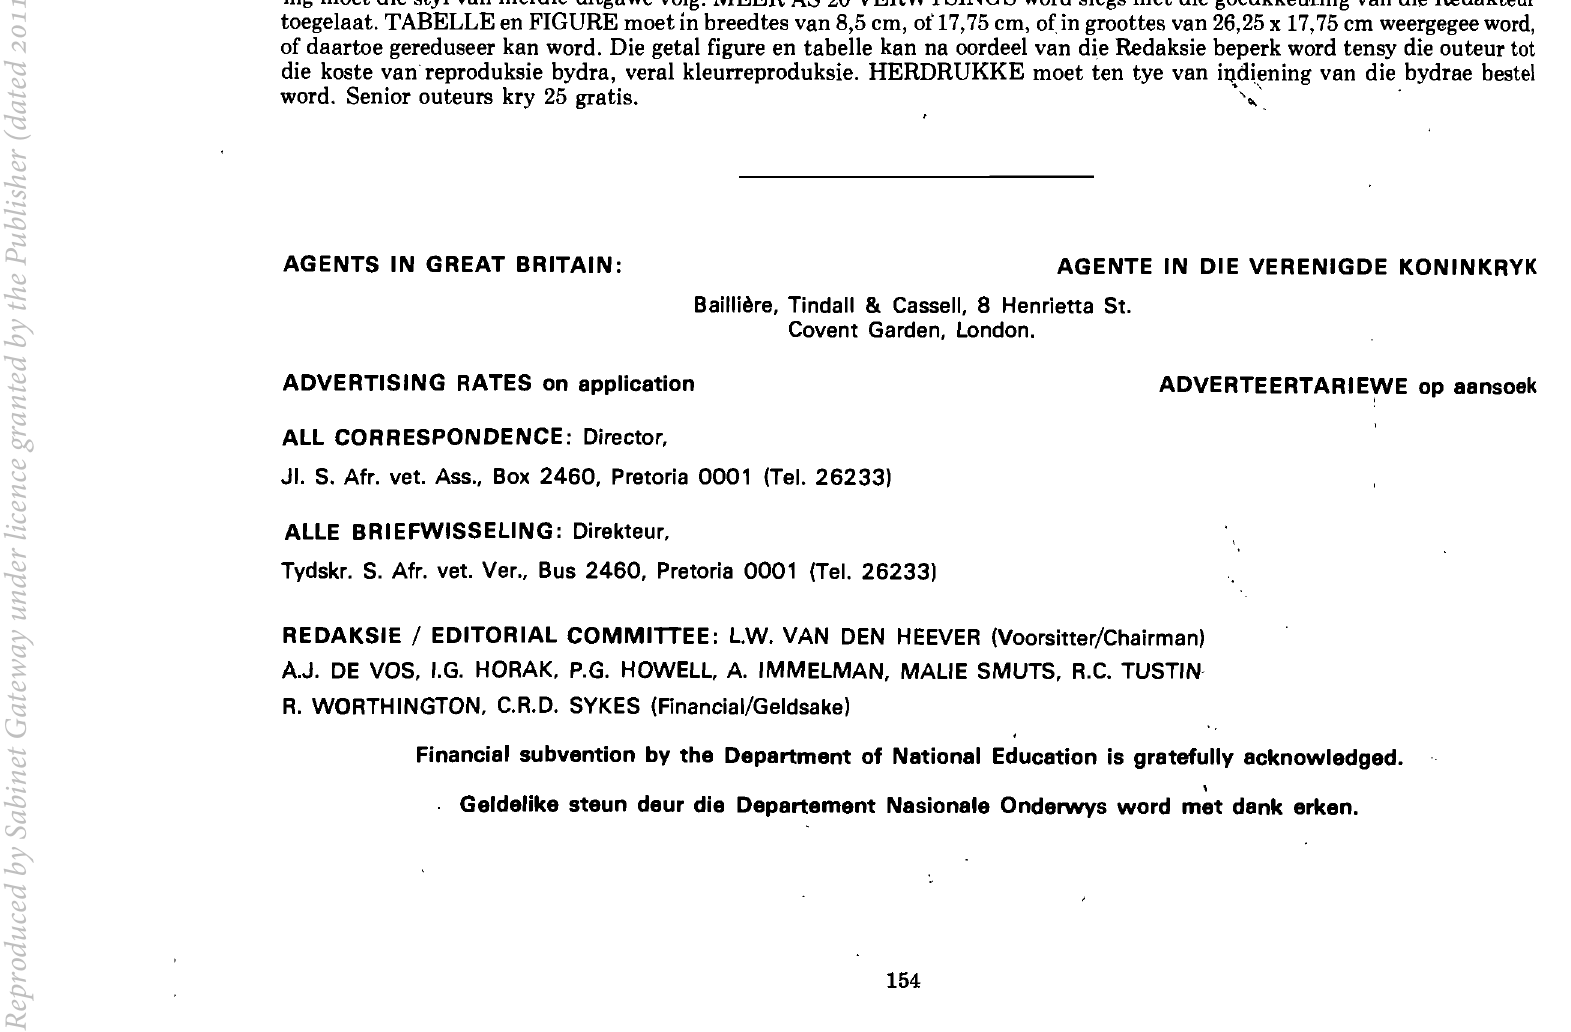
TYDSKRIF VAN DIE SUID-AFRIKAANSE VETERINERE VERENIGING Die TYDSKRIF is die offisiele mondstuk en eiendom van en word gepubliseer deur die Suid-Afrikaanse Veterinere Vereniging. Dit verskyn kwartaalliks en word aan sake van algemene veeartsenykundige belang ge_wy. Bydraers tot hierdie Tydskrif maak hul stellings en lug hul menings slegs op eie verantwoordelikheid; sodanige stellingos word nie noodwendig deur die Redaksiekomitee onderskryf nie en die menings gee nie noodwendig die Komitee se menings weer nie. Kopeireg word op al die letterkundige inhoud van die Tydskrif voorbehou. INTEKENING - 'n Eksemplaar van elke uitgawe word gratis aan aile volwaardige lede van die Vereniging gestuur. Die in· tekengeld vir persone wat nie lede is nie beloop R12,50 per jaar, posvry per land-of seepos. VORIGE UITGAWES . . \ R4,00/eksemplaar. - '. BYDRAES - Die Redaksie sal aile bydraes van veeartsenykundige -belang vir pubiikasie: 90nyeeg. Dubbel7gespasieerde, noukeurig hersiende, getikte manuskripte moet in triplikaat (oorspronklike en twee afskrifte) ing~dien word, Opset en verwys ing moet die styl van hierdie uitgawe volg. MEER AS 20 VERWYSINGS word slegs met die goedkkeuring van die Redakteur toegelaat. TABELLE en FIGURE moet in breedtes van 8,5 cm, of 17,75 cm, of in groottes van 26,25 x 17,75 cm weergegee word, of daartoe gereduseer kan word. Die getal figure en tabelle kan na oordeel van die Redaksie beperk word tensy die outeur tot die koste van reproduksie bydra, veral kleurreproduksie. HERDRUKKE moet ten tye van i~di~ning van die bydrae bestel word. Senior outeurs kry 25 gratis. ',,'